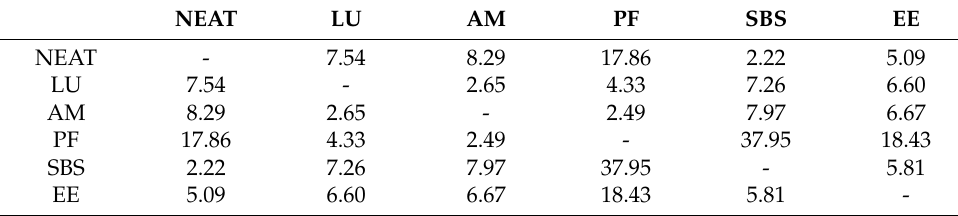
Table 13. Effect sizes of